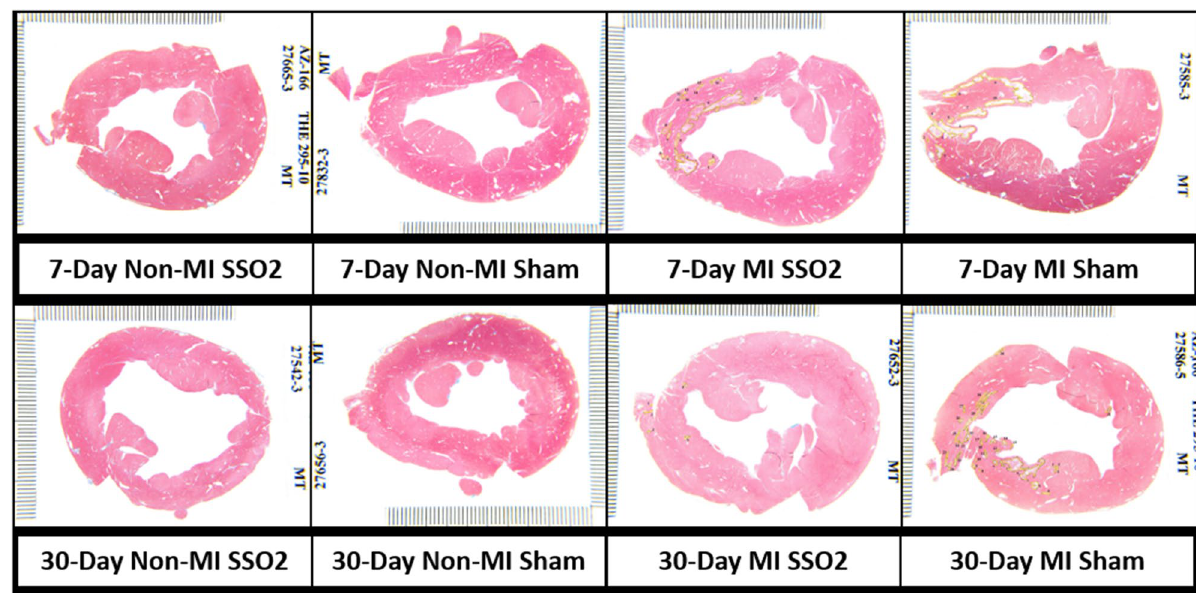
Figure 2. Side-by-side comparison of representative mid-basal left ventricular cross-sections from all 8 study subgroups. In the MI groups, areas of myocardial necrosis/scars, as defined by the study pathologist, are outlined by yellow